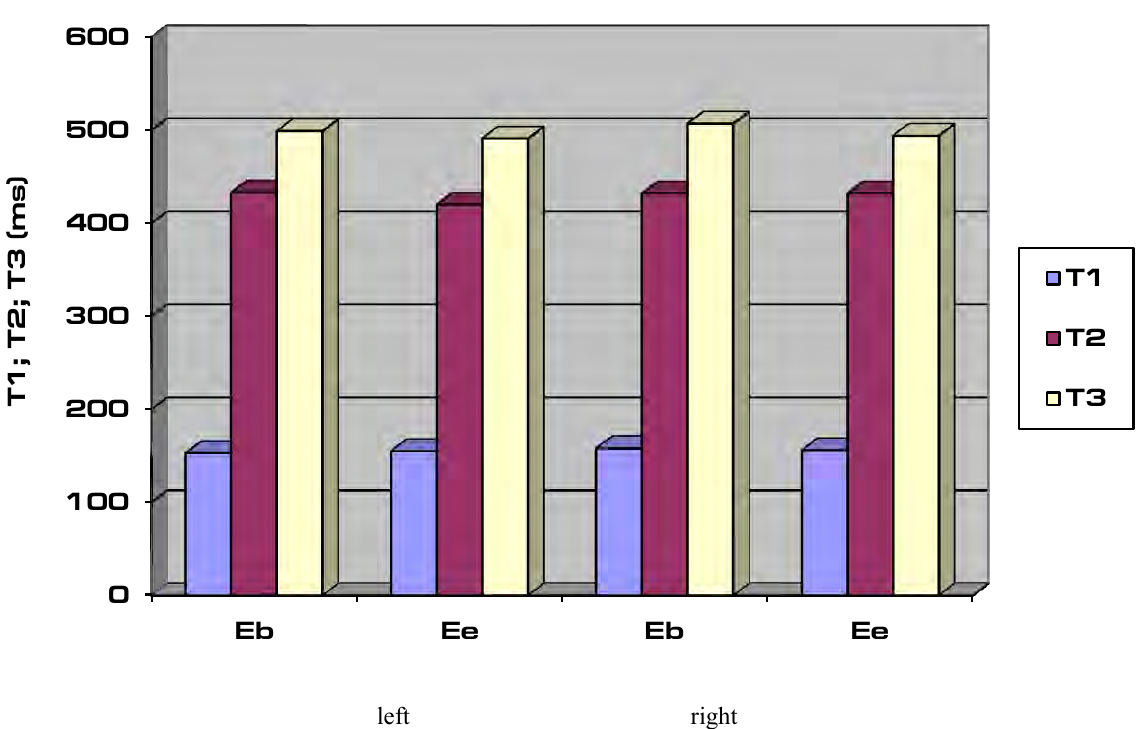
left right Figure 4. Temporal descriptions of passing of pulse wave on the shallow, middle and main blood vessels of cerebrum (left and right hemisphere) at sportsmen’s (Greek-Roman fight) before and after paravertebral miorelaxation: T1; T2; T3 - time of passing of pulse wave between the RE points; RI; RL on rheoencephalography; Eb - beginning of experiment; Ee - end of